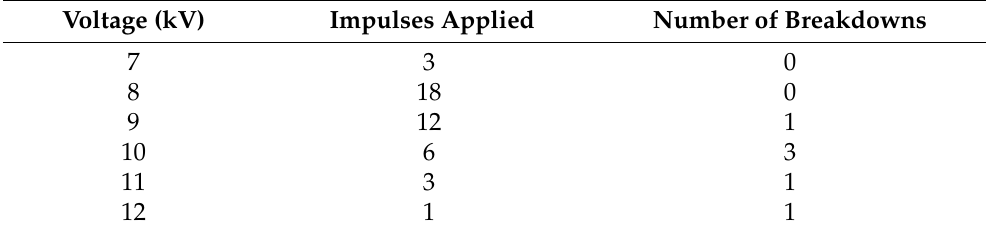
Table 6. Impulse test applied with and without breakdown for NF-impregnated